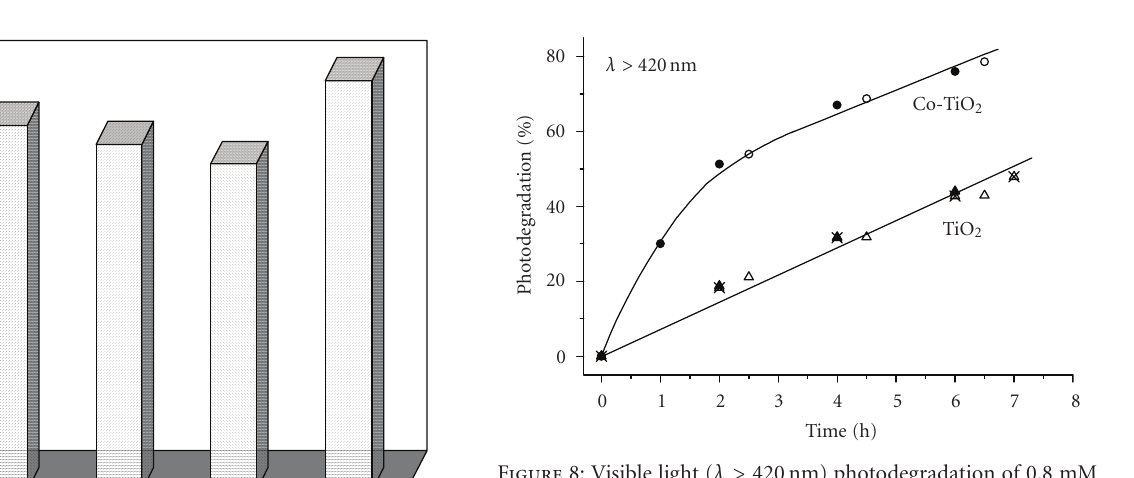
Figure 8: Visible light ( λ > 420 nm) photodegradation of 0.8 mM 2,2 (cid:6) -bis(4 (cid:6) -hydroxyphenyl) propane (Bisphenol A), as a function of time in aqueous suspensions of TiO 2 and Co( x %)-TiO 2 , where the degree of doping x % is 0.5. The final calcination temperature was 400 ◦ C for 30